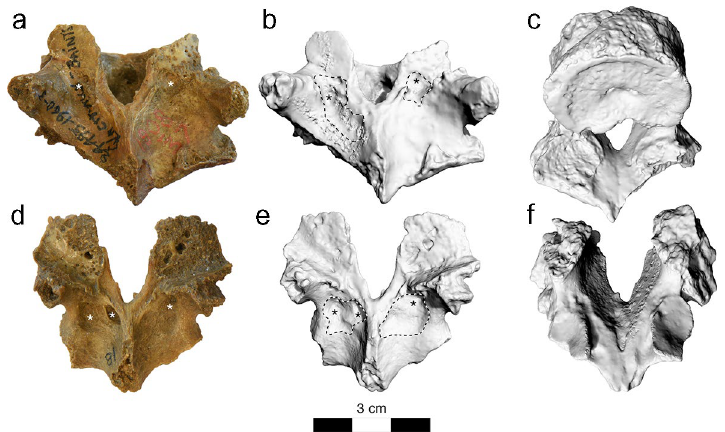
Figure 5. La Chapelle-aux-Saints 1 thoracic vertebrae 9 and 10, showing erosion of the facet joints T9/T10. ( a ) photograph of T9, dorsal view; the left superior facet joint of T9 is unaffected, while the right superior facet joint shows osteoarthritic changes with eburnation; the left inferior facet joint of T9 is broken off, the right inferior facet joint is severely remodelled and shows multiple fine erosions, ( b ) 3D surface scan of T9, dorsal view, ( c ) 3D surface scan of T9, oblique inferior view. ( d ) photograph of T10, dorsal view, ( e ) 3D surface scan of T10, dorsal view, ( f ) 3D surface scan of T10, oblique inferior view; the inferior facet joints of T10 are unaffected. Possible erosive defects caused by space-occupying granulomatous processes are marked with asterisks and dashed lines along their contours on the 3D scans.